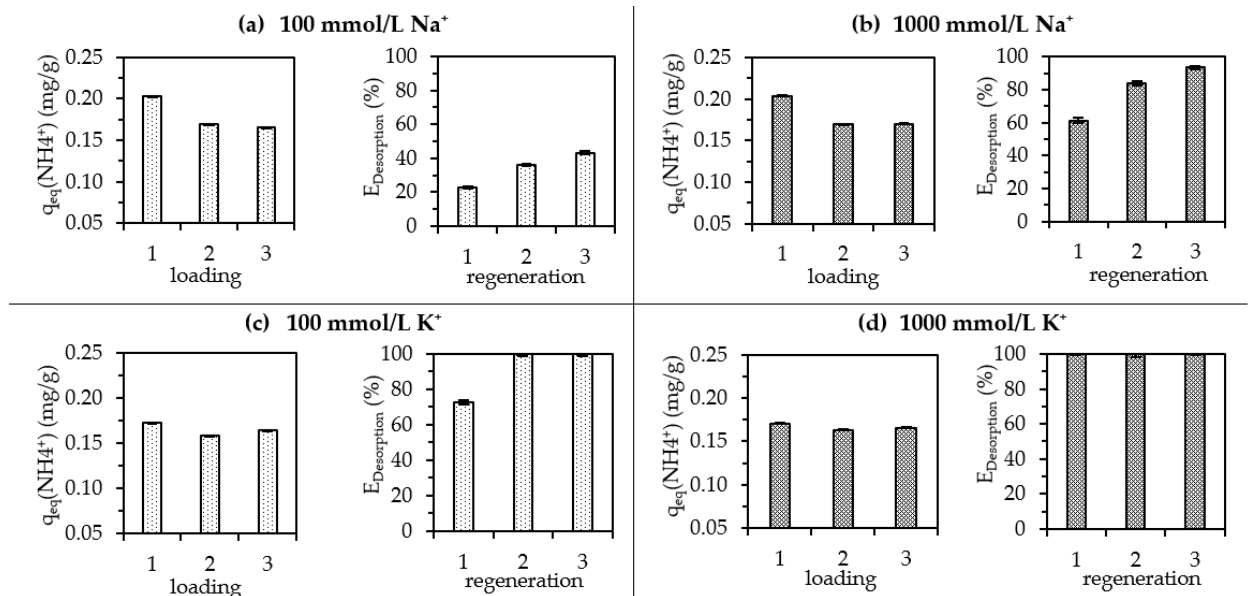
Figure 8. Sorption capacities and regeneration efficiencies during multiple rounds of NH 4+ load- ing and regeneration (matrix: ultrapure water; t eq : 14 d; pH 0 : 5.9; c 0 (NH 4+ ) = 0.71 mmol/L; c 0 (Na + , K + ) = 100, 1000 mmol/L; w / v = 100 g Z /L; T = 22 ◦ C; grain size: 8–16 mm; n =